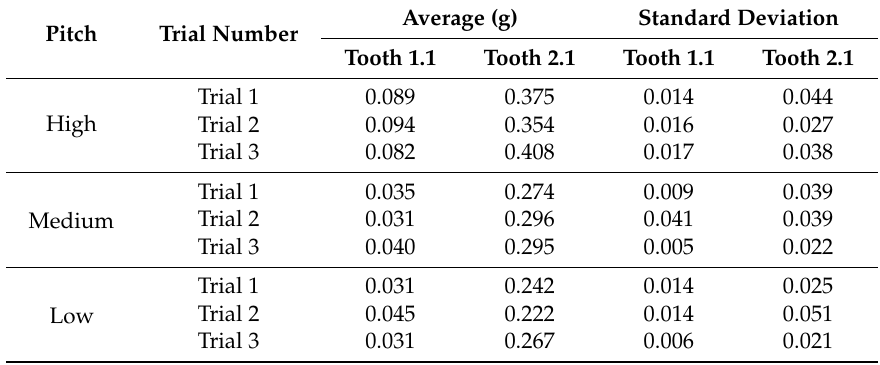
Table 3. Piezo-resistive sensors’ results of three different pitches; high, medium and low, registered at the upper central incisors during the embouchure